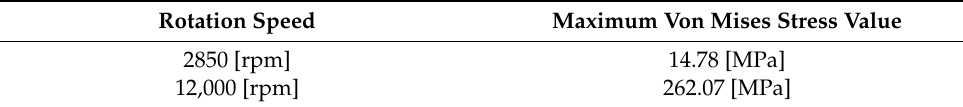
Figure 14. Mises stress analysis result ( a ) rated speed; ( b ) maximum speed. Table 5. Mechanical stress analysis result.